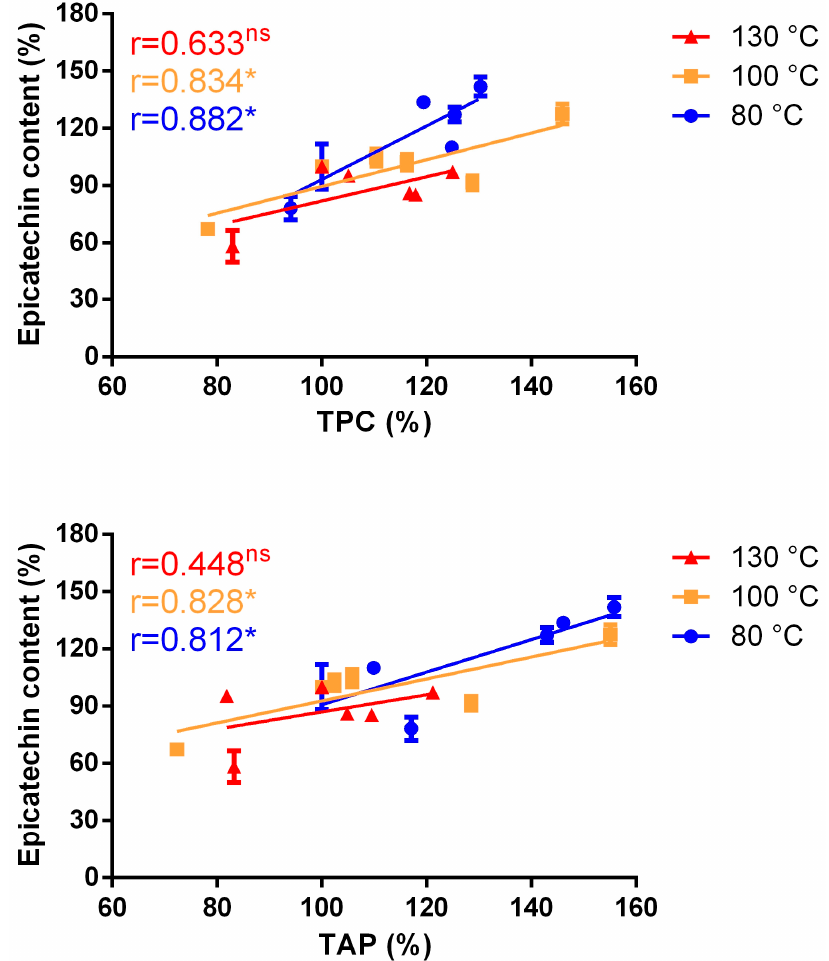
Figure 6. Correlation plots of TPC (%) and epicatechin (%) ( upper plot) and of TAC (%) and epicatechin (%) ( lower plot). Values have been normalized (100%) for the values of the relative cocoa bean sample. * significant ( p < 0.05); ns, not significant ( p > 0.05).